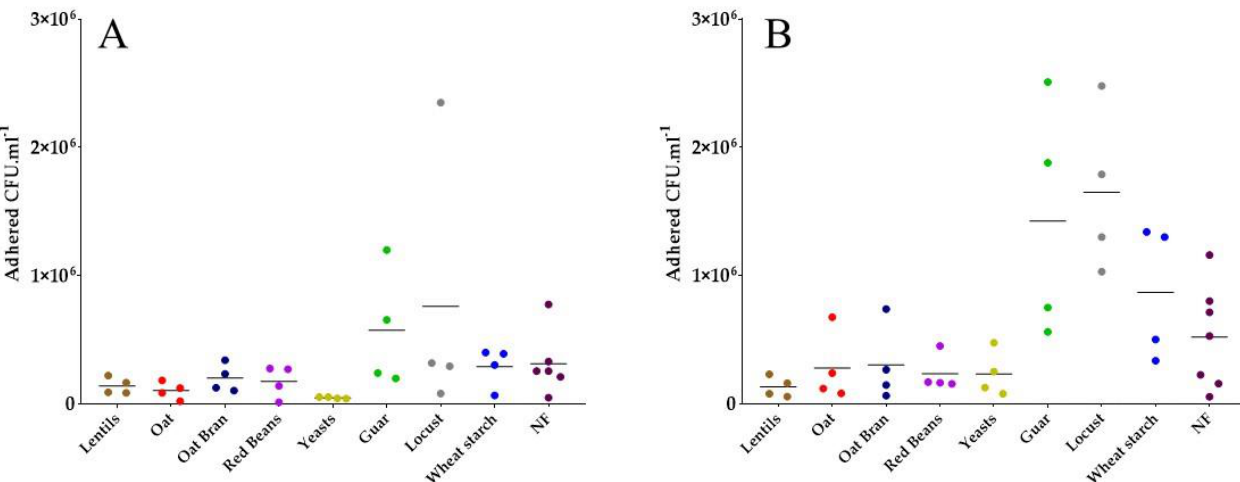
Figure 3. Effect of fiber-containing products on ETEC adhesion on mucin beads, when inoculating with 10 7 ( A ) or 10 8 ( B ) CFU · mL − 1 , during 30 min ( A ) or 1 h ( B ) contact period. Fiber-containing products were tested at 2 g · L − 1 of final fiber content. Each biological replicate and its mean is represented ( n = 4–7). Results are expressed as adhered CFU · mL − 1 of crushed bead solution. No significance with the control condition was found according to Tukey’s multiple comparison tests. NF = control condition with no product added.